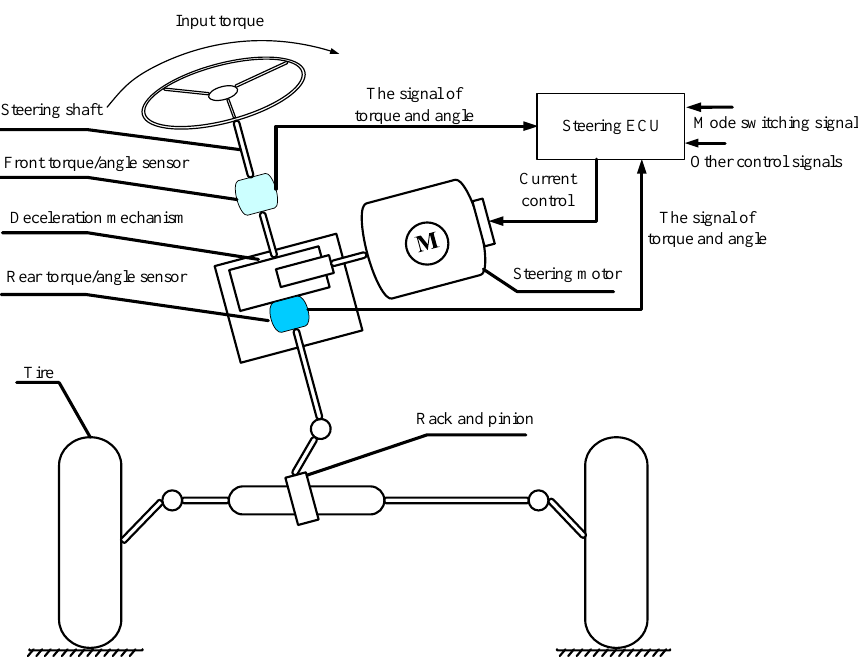
Figure 4. Novel Electric Power Steering (EPS) system